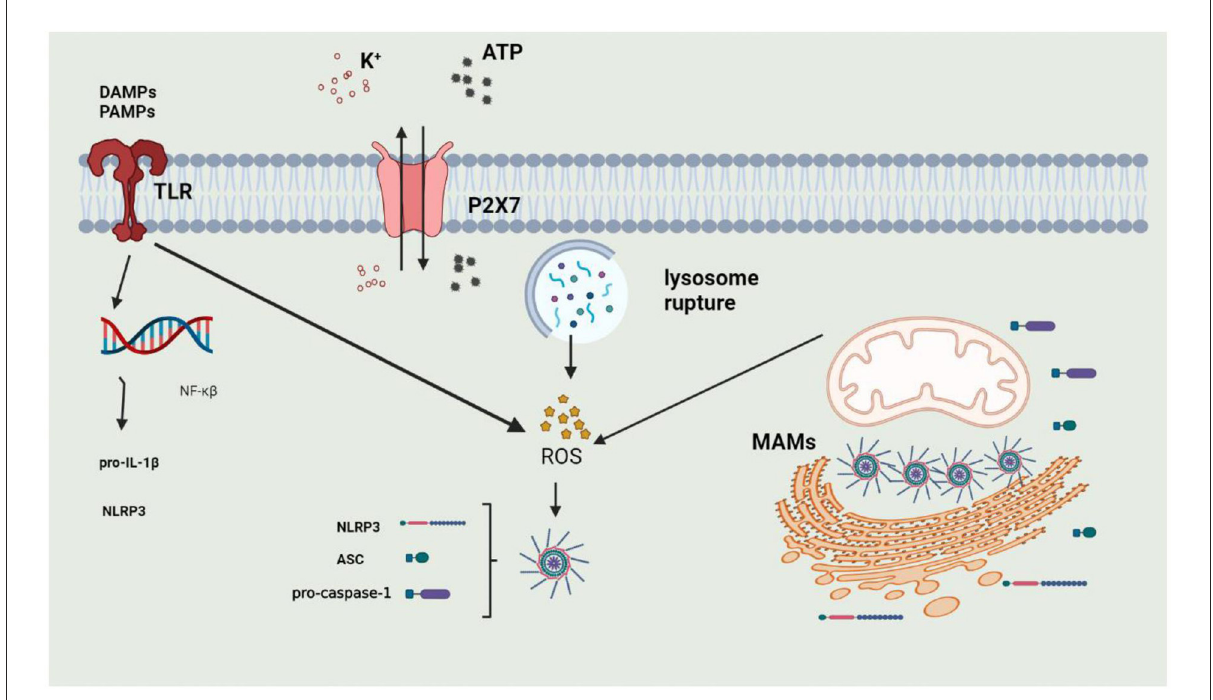
FIGURE3 The process of activation of NLRP3 Inflammasome. 1. Priming: when DAMPs or PAMPs are recognized by TLRs or under stimulation of extracellular ATP, intracellular NF- κβ enters into the nucleus to induce the expression of NLRP3 and Pro-IL-1 β ; 2. activation: NLRP3 inflammasome can be activated by potassium outflux, lysosomal rupture or mitochondrial